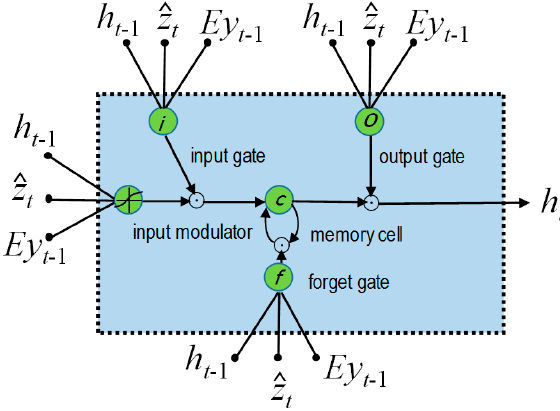
Figure 8. The structure of the LSTM network.